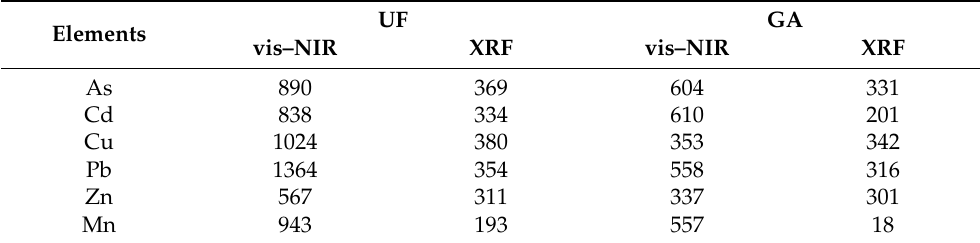
Table 3. Number of spectral variables selected by Univariate filter (UF) and genetic algorithm (GA) from vis–NIR (out of 2051) and XRF (out of 716)